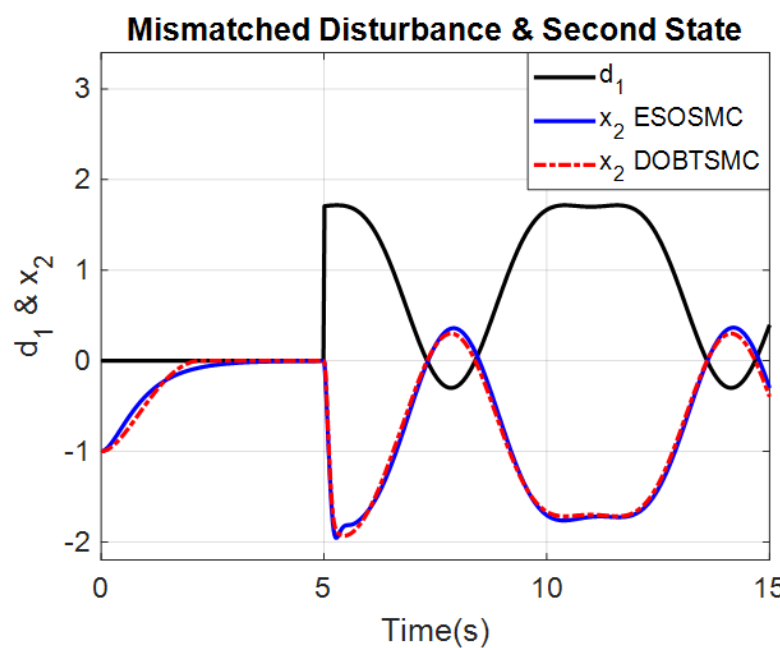
Figure 2. Mismatched disturbance and second state response trajectories.